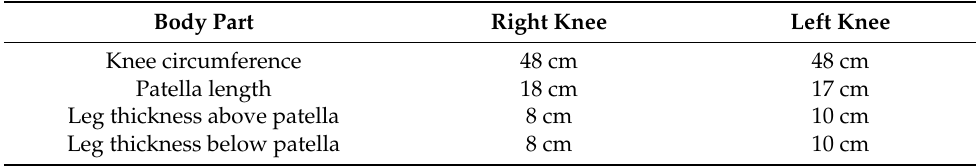
Table 1. Parameters considered to ensure homogeneity of the